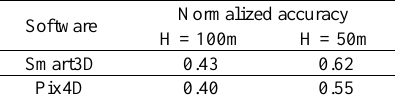
Figure 2, selecting one skip image from 17 continuous images), and six images (Case 3 in Figure 2, selecting two skip images from 17 continuous images) were verified.